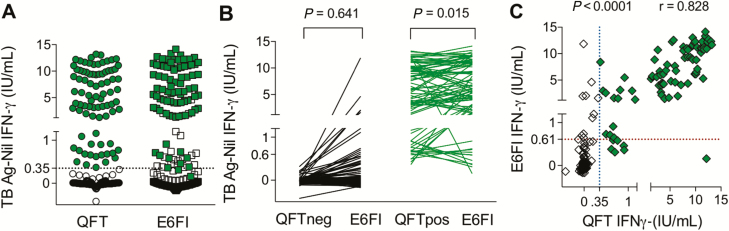
ESAT-6–free IGRA diagnostic accuracy in healthy South African adolescents. Blood was collected from QFT-negative (n = 117, open symbols) and QFT-positive (n = 83, filled symbols) healthy South African adolescents (cohort 3) in QFT and ESAT-6–free IGRA (E6FI) tubes and stimulated for 16–20 hours at 37°C; the IFN-γ concentration was measured by QFT enzyme-linked immunosorbent assay. A, Distribution of IFN-γ values measured by QFT and E6FI in all participants. The dotted line denotes QFT cutoff. B, Paired analysis (Wilcoxon matched-pairs signed rank test) of IFN-γ values measured by QFT and E6FI (TB Ag – Nil) in QFT-negative and QFT-positive adolescents. C, Correlation between IFN-γ values obtained by QFT and E6FI in all participants was assessed using the Spearman test. The dotted lines denote assay cutoffs: 0.35 IU/mL for QFT (vertical line) and 0.61 IU/mL for E6FI (horizontal line). Abbreviations: Ag, antigen; ESAT-6, early secretory antigenic target; IFN-γ, interferon-gamma; IGRA, interferon-gamma release assay; QFT, QuantiFERON-TB Gold In-tube; TB, tuberculosis.